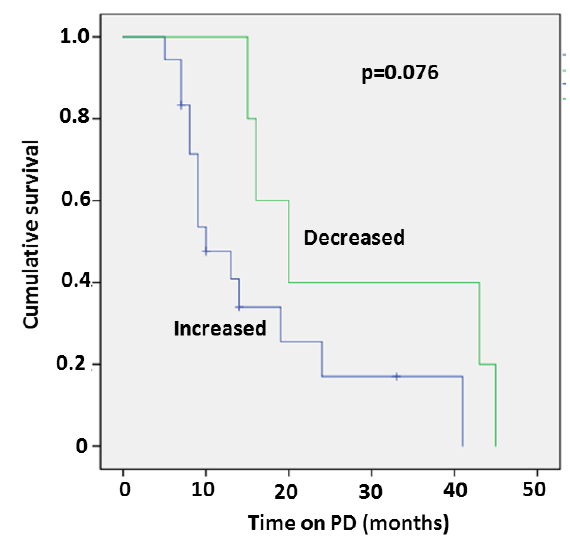
Figure 1. Kaplan–Meier survival curve of patients who demonstrated a decrease in all three fibrosis markers following PD treatment compared to other patients .